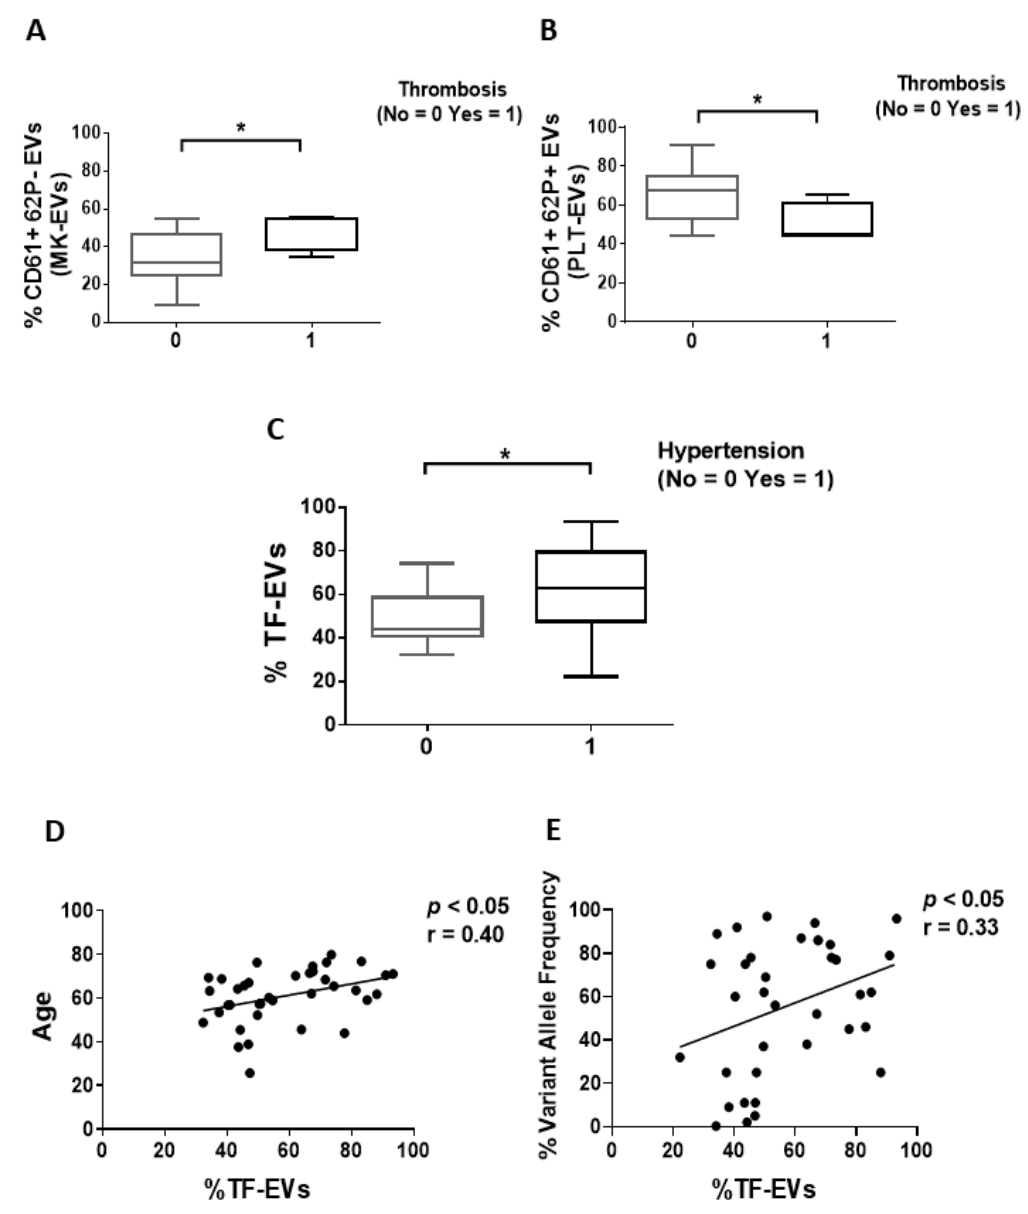
Figure 1. Proportion of circulating MK-, PLT-, and TF-EVs of PV patients. ( A , B ) Frequency of MK- and PLT-EVs in PV patients with ( n = 14) or without thrombosis history ( n = 24). ( C ) Frequency of TF-EVs of PV patients with ( n = 24) or without ( n = 14) hypertension. ( A – C ) Data are expressed as percentage of MK-, PLT-, and TF-EVs and presented as min to max with median (Mann–Whitney test; * p < 0.05). ( D , E ) TF-EV percentages of PV patients positively correlate with age and JAK2V617F-variant allele frequency (Spearman’s correlation test).